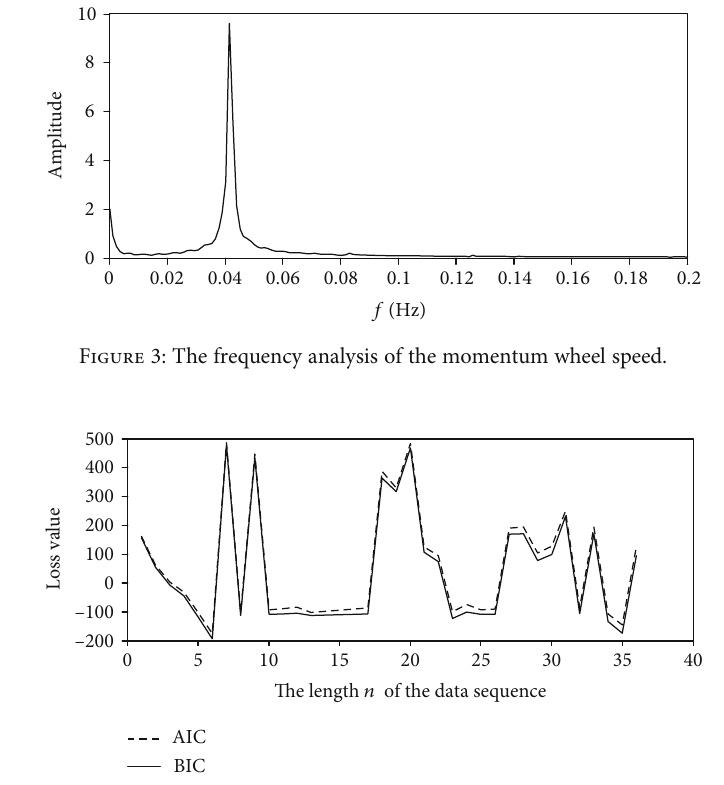
Figure 4: The loss value of AIC and BIC criterion under the length n of the data sequence.